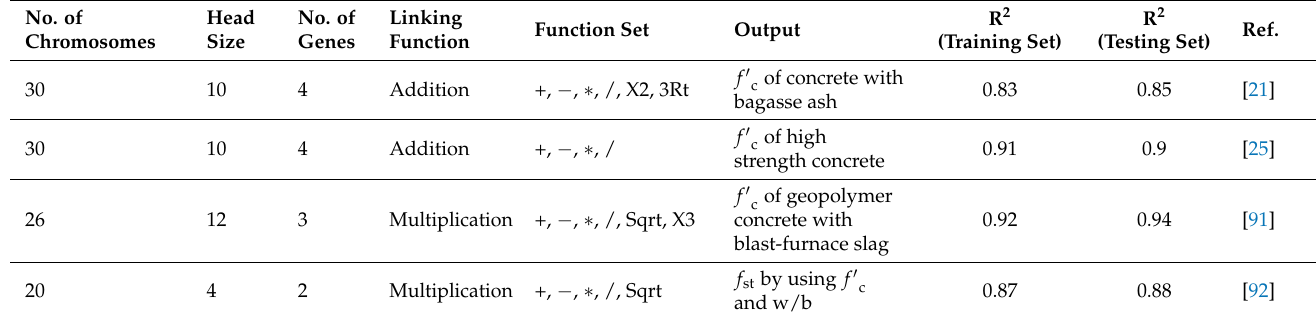
Table 3. Different parameters of the GEP algorithm used by researchers to obtain a reliable and robust